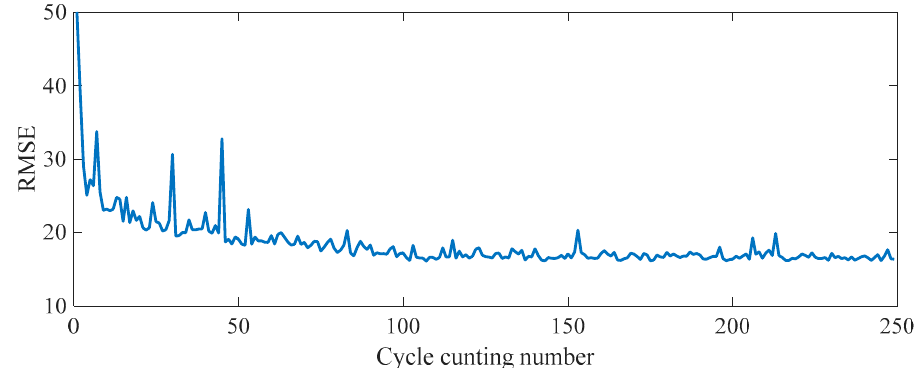
Figure 13. The validation performance of the proposed model after each cycle.